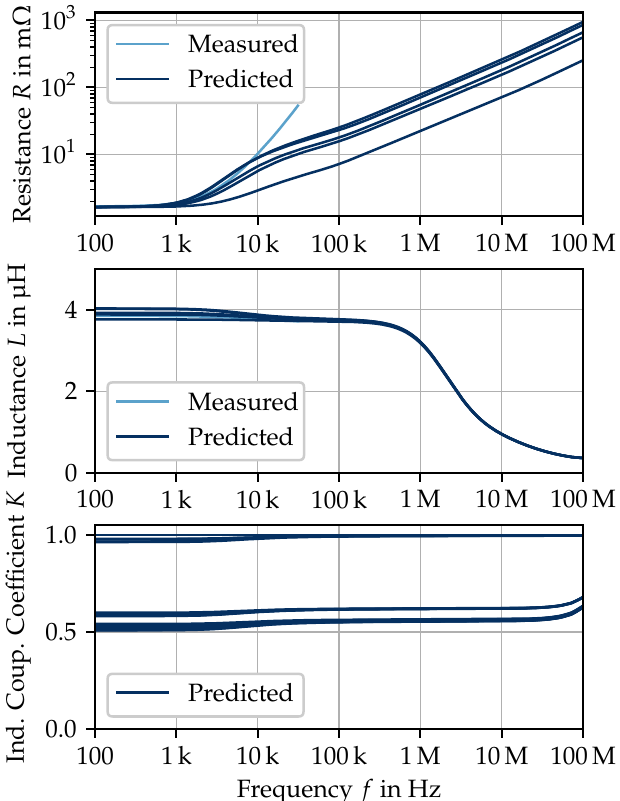
Figure 10. Magneto-harmonic field simulation results for turn resistance, turn inductance, and the inductive coupling coefficient on a turn-to-turn basis